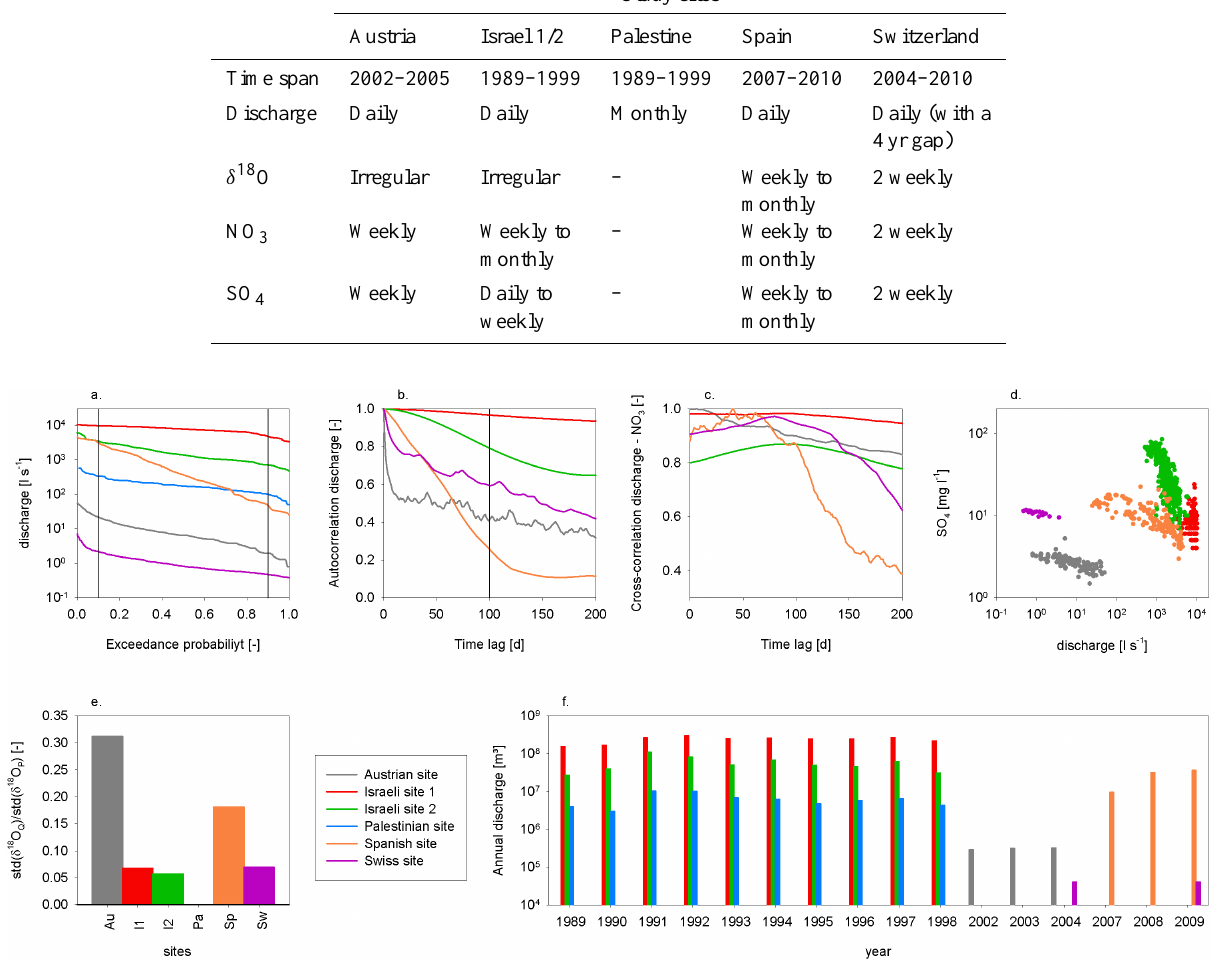
Fig. 2. Different hydrological and hydrochemical aspects of the system behaviour of the study sites: (a) flow duration curves, (b) autocor- relation of discharge, (c) cross-correlation of discharge and NO 3 , (d) correlation of discharge and SO 4 , (e) ratios of variability (standard deviations) in observed δ 18 O in discharge ( Q ) and precipitation ( P ), and ( f ) annual amounts of discharge.